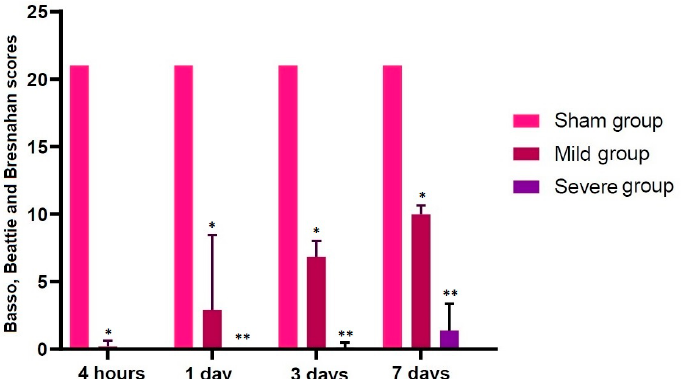
Figure 2. Locomotor rating scale scores. The locomotor rating scale scores remained constant in the sham group through all the time course, but the scores were drastically decreased in both the mild and severe groups when comparing with the sham group ( P < 0.05). Asterisks indicate significant differences between the same ones at P < 0.05. On histopathological findings, there were damages to only some part of the white and gray matter in the mild group. In the severe group, however, there was no remaining normal tissue in the white and gray matter; lesions of spinal cord were replaced by cavitation or fibrosis (Figure 3). Brain Sci. 2020 , 10 , x FOR PEER REVIEW